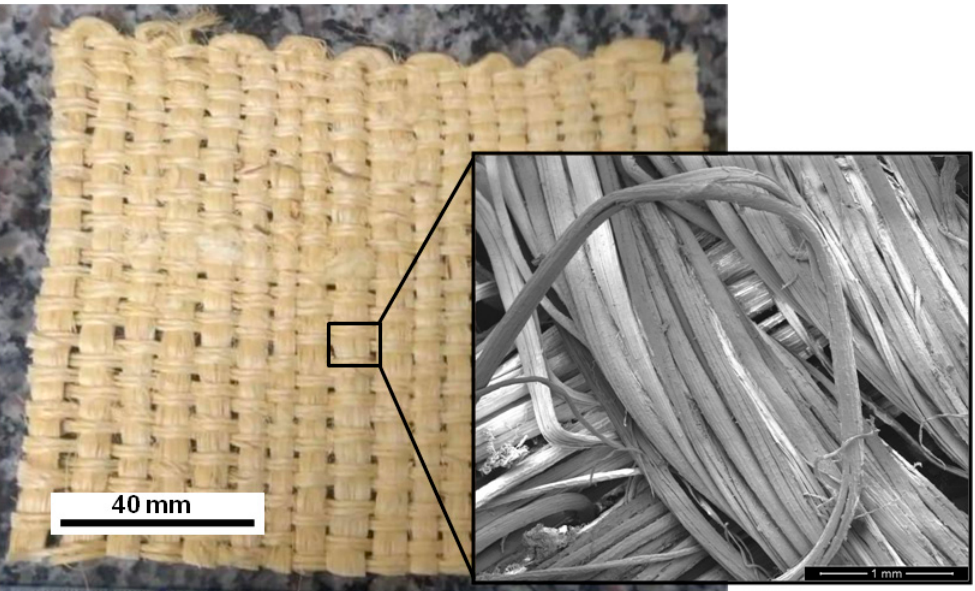
Figure 1. Plain woven fique fabric and microscopic inset of weaved fibers (adapted from [18]). As composite matrix, the commercial epoxy resin diglycidyl ether of the bisphenol-A (DGEBA) was used in a stoichiometric mixture which was hardened with a triethylenetetramine (TETA) catalyst of 13 parts per 100 of resin. Both DGEBA (~100% purity) and